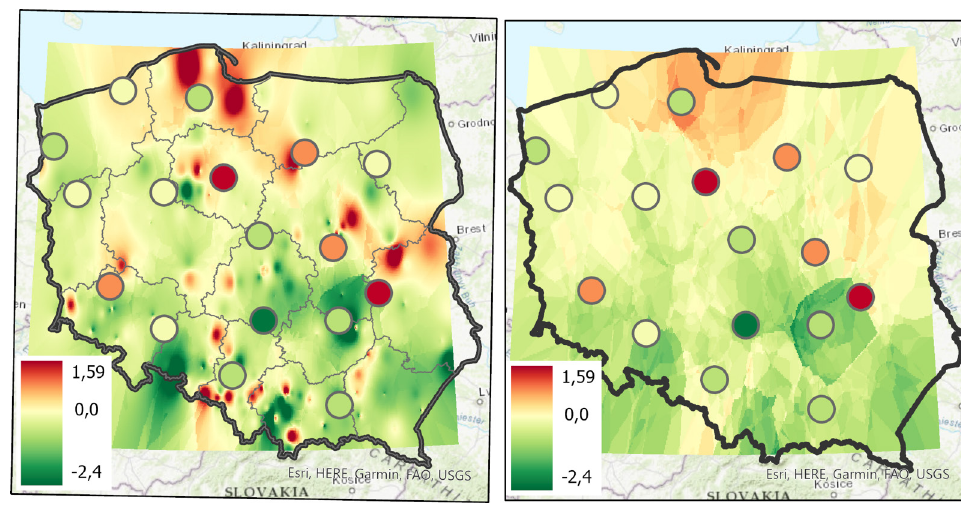
Tab. 1. Comparison of the modeled and actual trend values for PM10 dust concentration (source: Jackowska 2020)